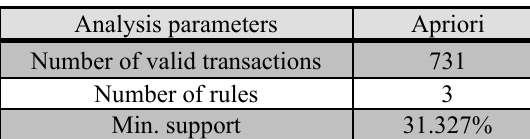
Table 17. Analysis of